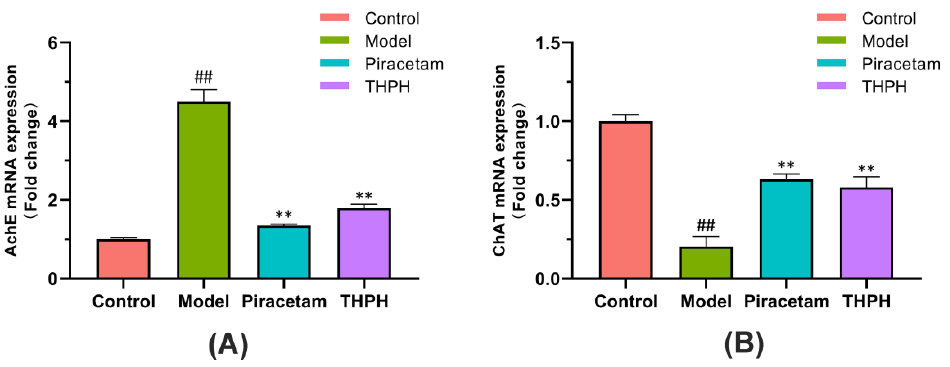
Figure 5. Effect of THPH on the mRNA expressions of ( A ) AchE and ( B ) ChAT in scopolamine- induced amnesia mice. Data are presented as means ± SEM. ## p < 0.01 compared to the control group; ** p < 0.01 compared to the model